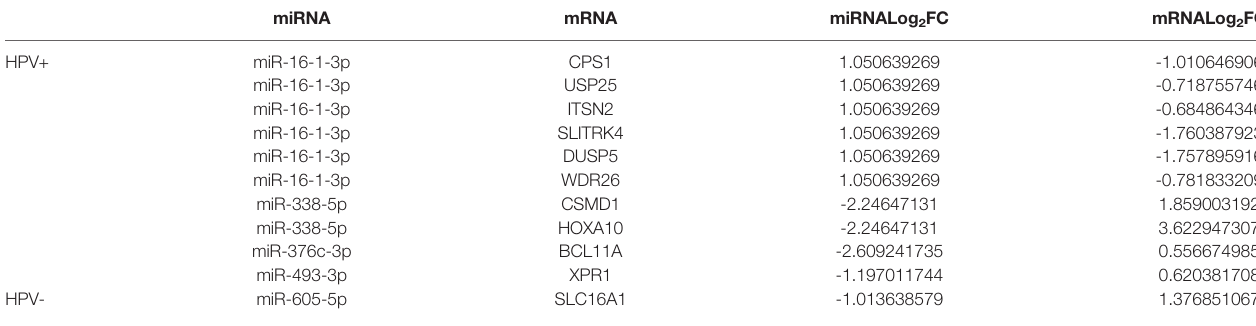
TABLE 2 | Targeted mRNA of the survival-related miRNAs for HPV+ and HPV − HNSCC